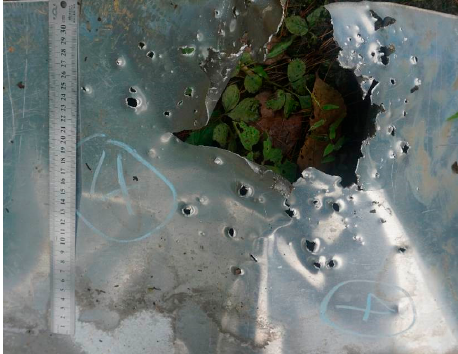
Figure 11. Typical damaged aluminum target plate.